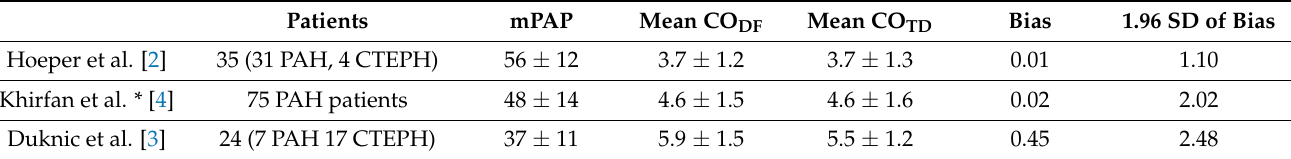
Table 1. Studies comparing CO TD and CO DF in